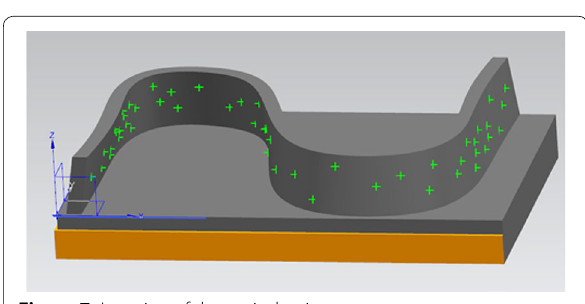
Figure 7 Location of theoretical (1) GUMM The uncertainties of measuring points ux ux = 5.97 µ m, uy = 0.40697 µ m, uz = 1.3 µ m. Covariance matrix of the best transformation matrix is shown in Table 5.